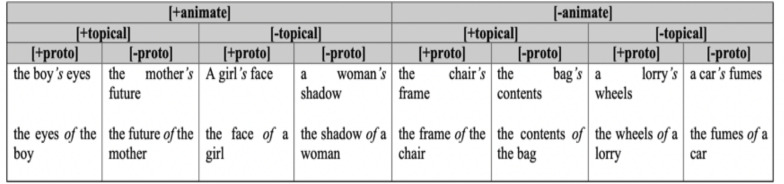
Genitive framework from Rosenbach (2001).